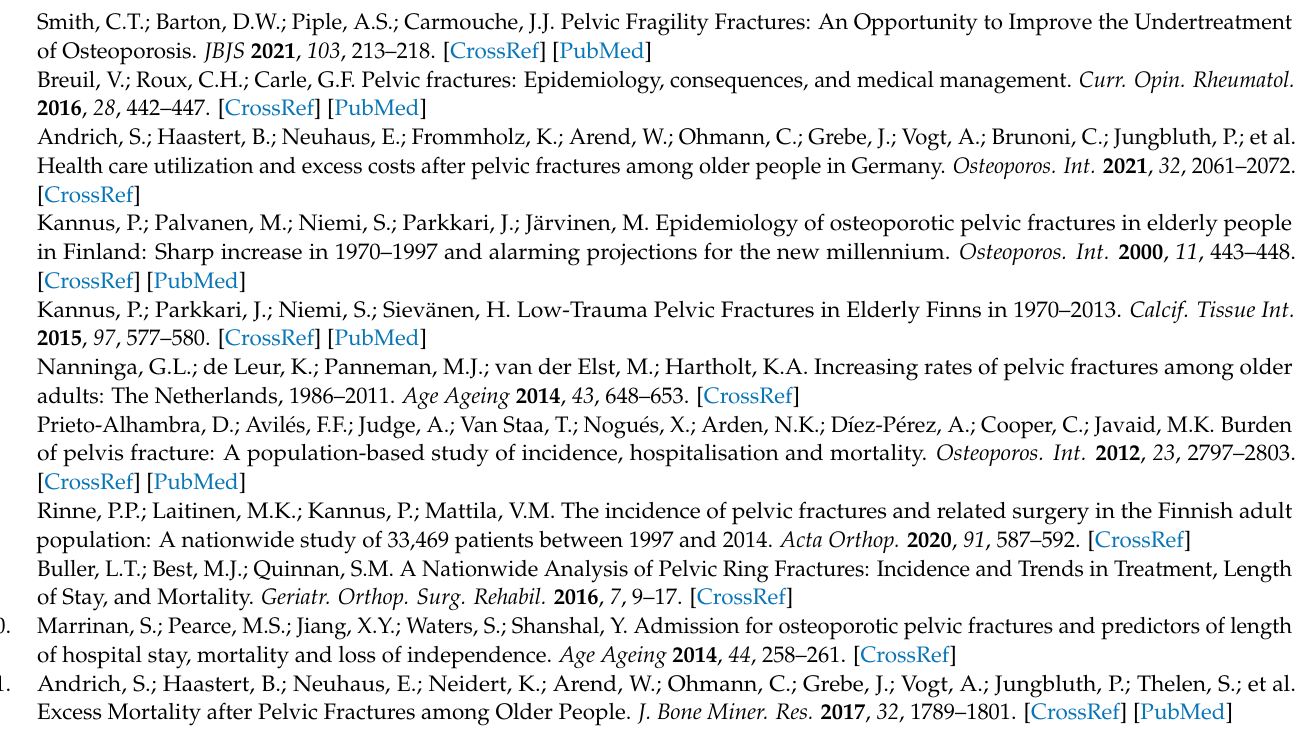
Table S4: 7-day and 30-day all-cause mortality in a cohort of pelvic fracture patients and controls; Supplementary Figure S1: The Log ( − Log) plots for assessment of proportional hazards in the age category of 50–64 years old; Supplementary Figure S2: The Log ( − Log) plots for assessment of proportional hazards in the age category of ≥ 65 years